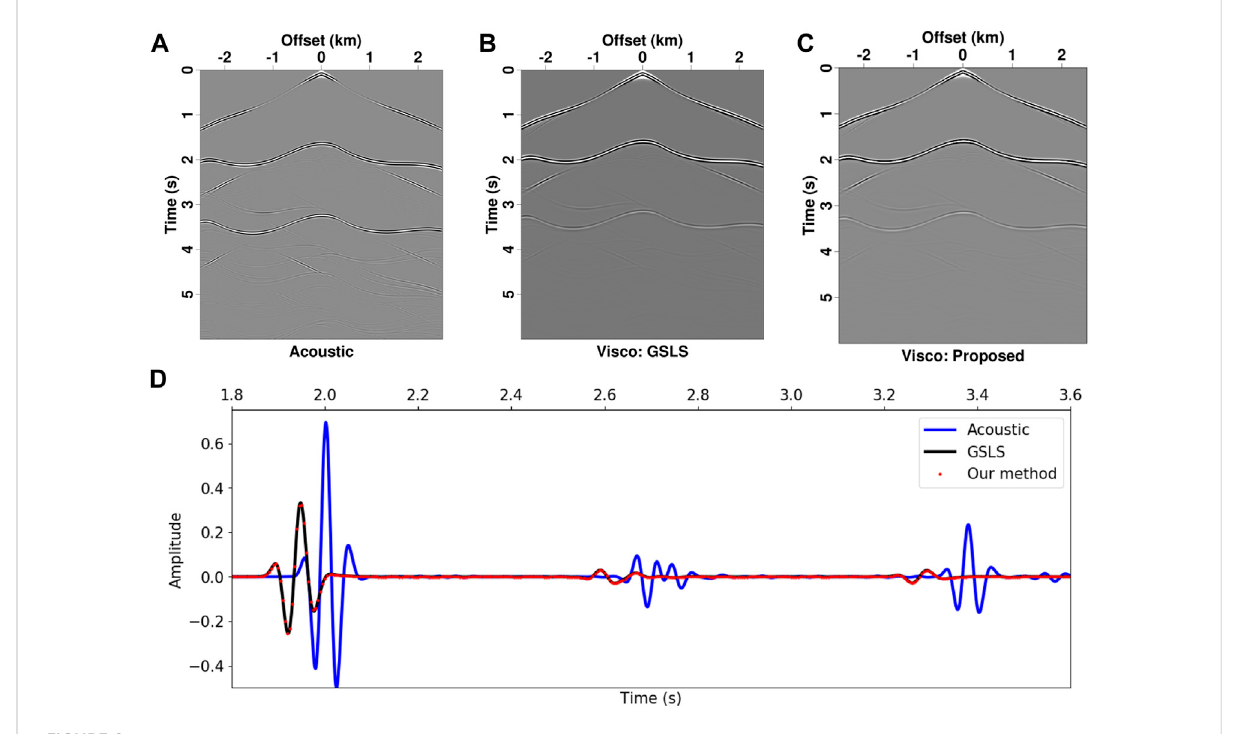
FIGURE 9 (A – D) Common-shot gathers simulated with a top free-surface boundary for the three-layer model. The panel noti fi cations are the same as in Figure